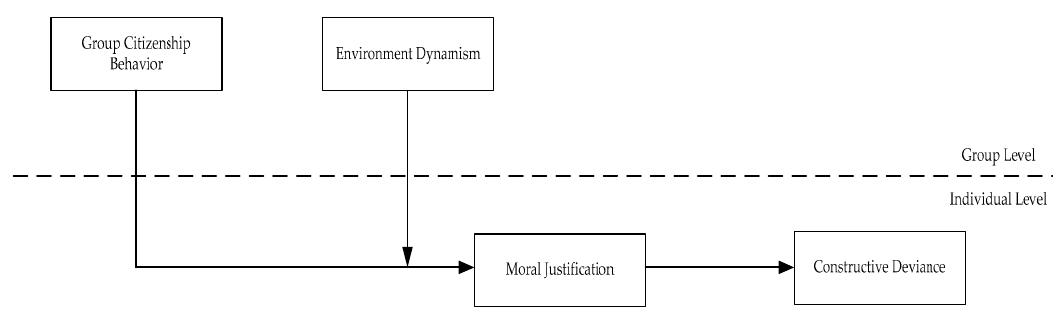
Figure 1. The research conceptual model.